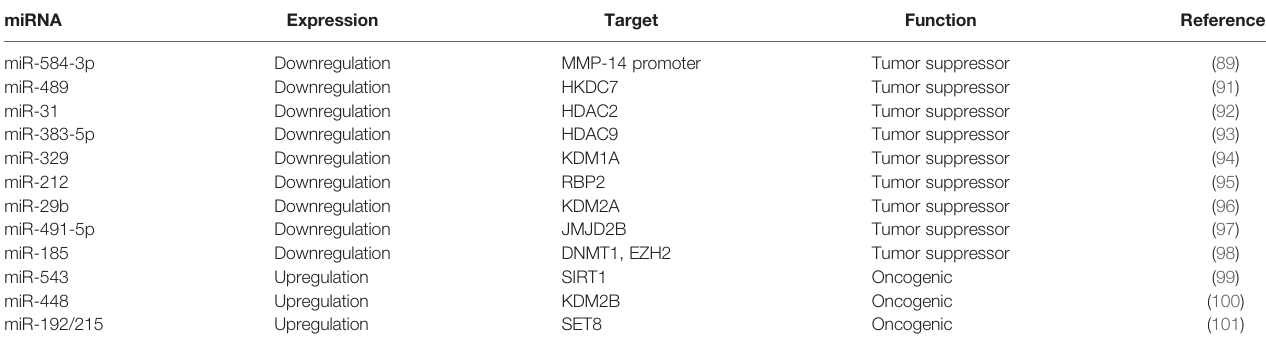
TABLE 1 | miRNAs regulate histone modi fi cation in GC. miRNA